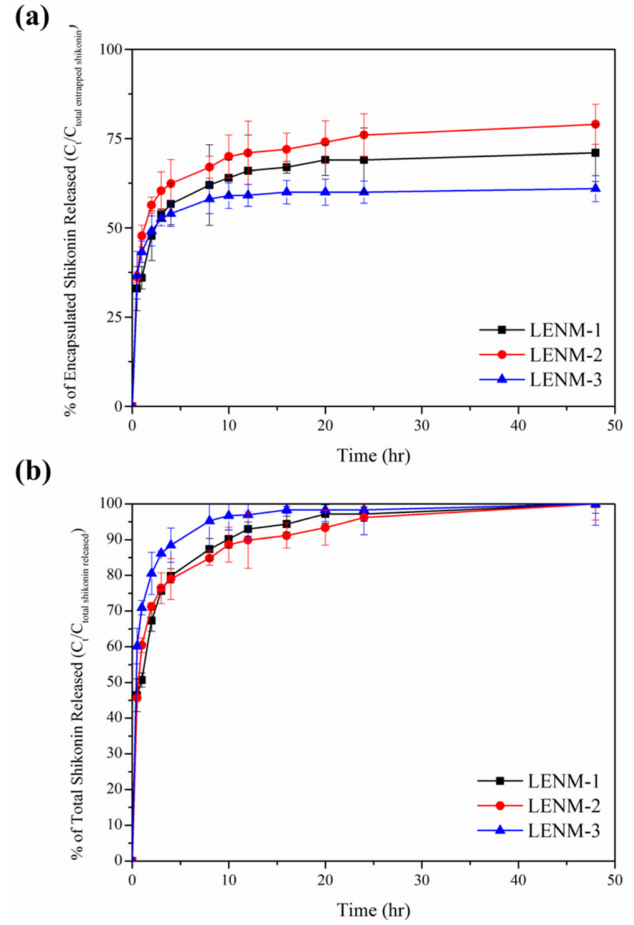
Figure 4. Drug release curve of LENMs representing ( a ) the percentage of shikonin released in regard to the total entrapped drug versus time, ( b ) the percentage of shikonin released in regard to the total released drug versus time. Release medium: phosphate buffered saline (PBS, pH 7.4) + 1% dimethyl sulfoxide at 37 ◦ C for 48 h; C t , amount of shikonin released at a given time; C total entrapped shikonin , total amount of shikonin entrapped in the LENM; and C total shikonin released , total amount of shikonin released from the LENM. Each value represents the mean ± SD; n =